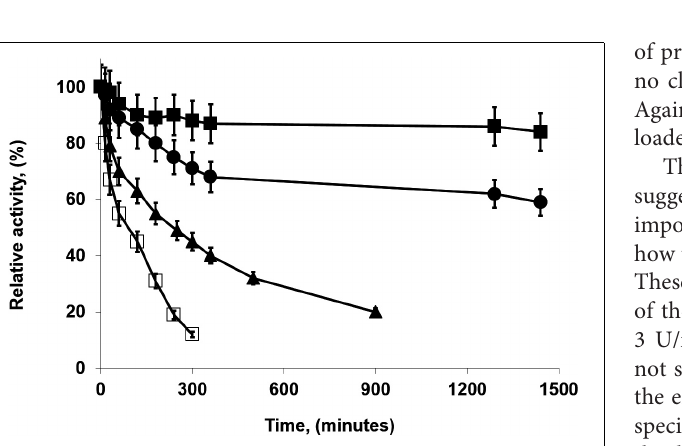
FIGURE 4 | Inactivation courses of high loaded PFL preparations (60 mg/g). The biocatalysts were inactivated at 75 ◦ C, in presence of 50 mM Tris buffer, pH 7.0. Other specifications are described in section “Methods.” Solid squares: Immobilization in 5 mM Tris buffer with 10 mM CaCl 2 at pH 7.0; Solid circles: Immobilization in 100 mM sodium phosphate buffer at pH 7.0; Solid triangles: Immobilization in 5 mM sodium bicarbonate buffer with 250 mM NaCl at pH 9.0; Empty squares: Immobilization in 5 mM Tris buffer at pH